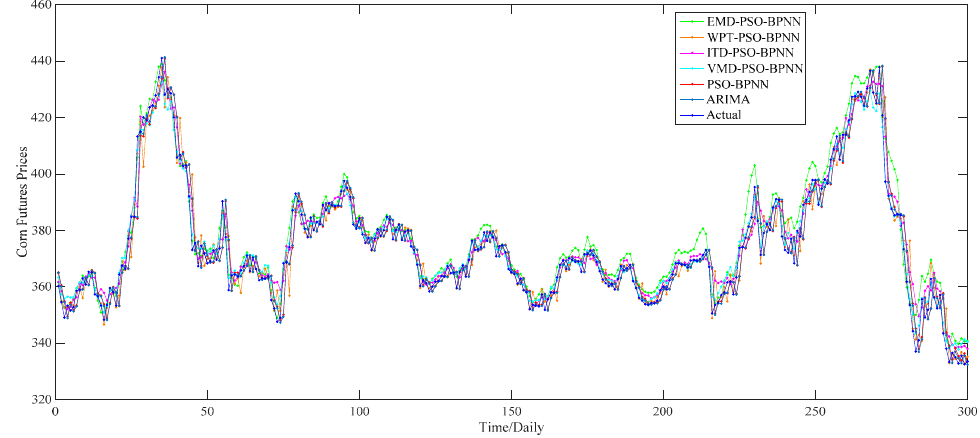
Figure 16. Decomposition results of the VMD method (corn).